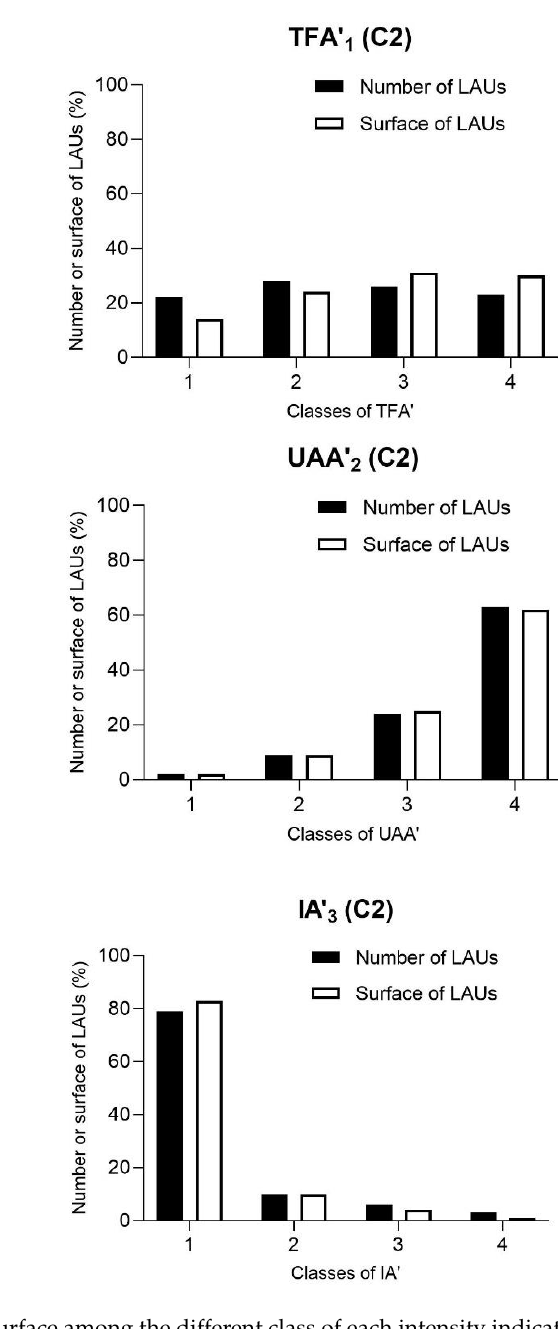
Figure 6. The percentage distribution of LAUs’ number and surface among the different class of each intensity indicator (TFA’ = total farm area, UAA’ = utilized agricultural area and IA’ = irrigated area) for the two census dates (C1 and C2).